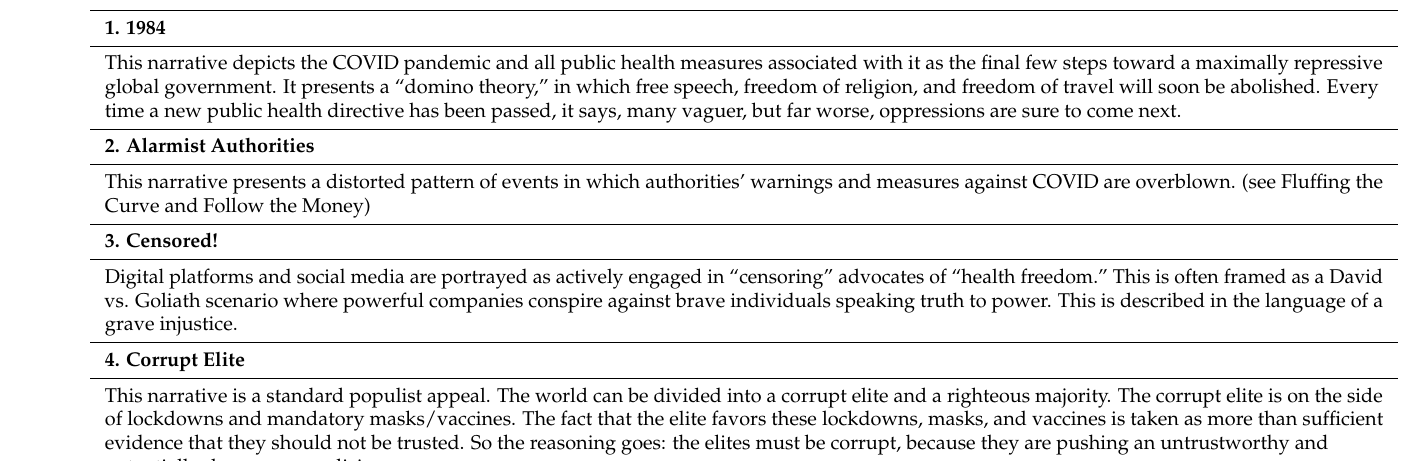
Table 3. Narrative tropes (organized by primary